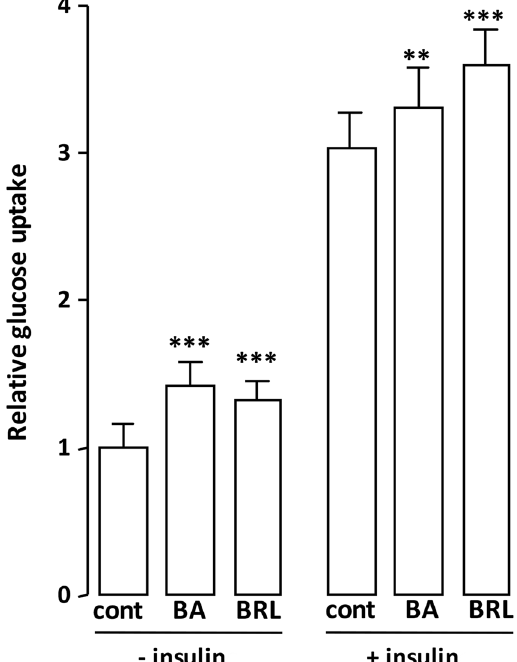
Figure 8. Cellular glucose uptake rate upon exposure to BA. Differentiated adipocytes were treated with BA (10 μ M) for 16 h prior to insulin (50 nM) stimulation, then cellular glucose uptake was determined. The PPAR γ agonist rosiglitazone (BRL, 0.1 μ M for 16 h) served as positive control for increased glucose uptake. Values are means ± SD expressed as fold relative to the respective untreated control (cont). ** P < 0.01, *** P < 0.001 (one- way ANOVA followed by Bonferroni post hoc